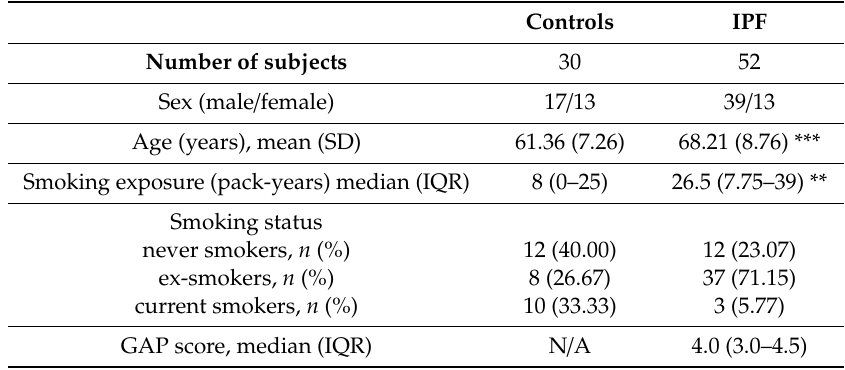
Table 1. Characteristics of study